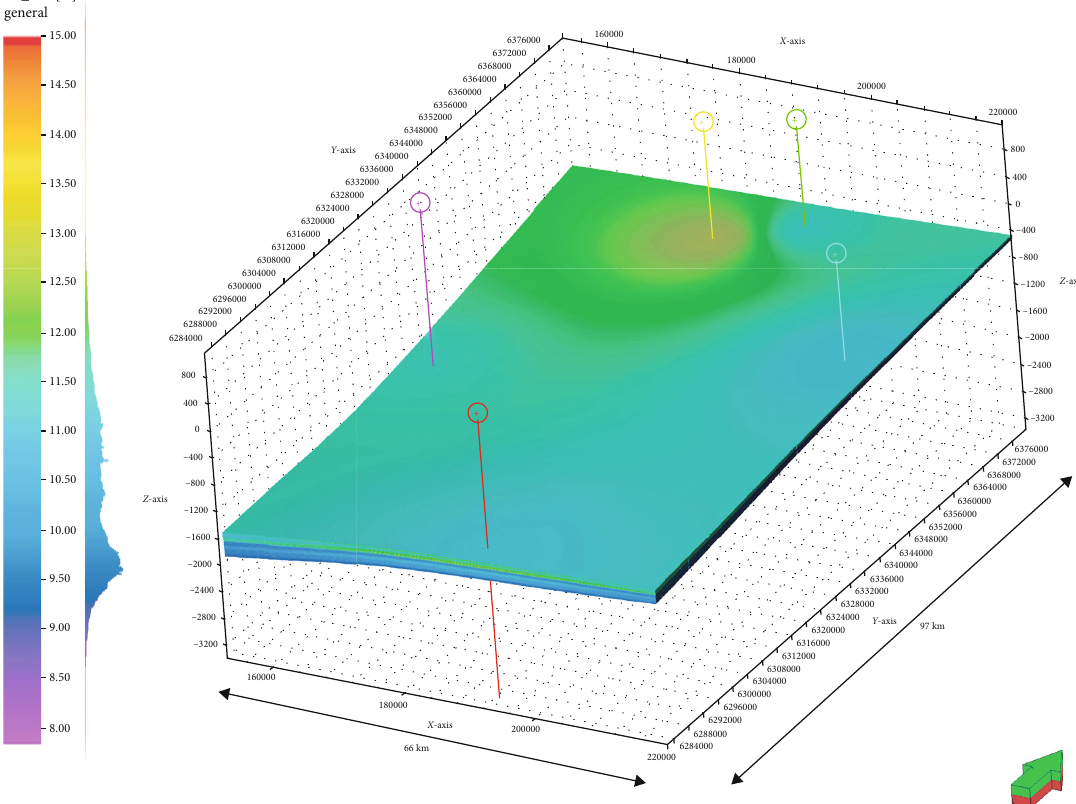
Figure 11: The three-dimensional model of northwestern area. It appears the separation of the upper and lower member of Montney Formation. The upper member represents higher volume of desorbed gas. In northwestern area shows the most concentrated and highest desorbed gas